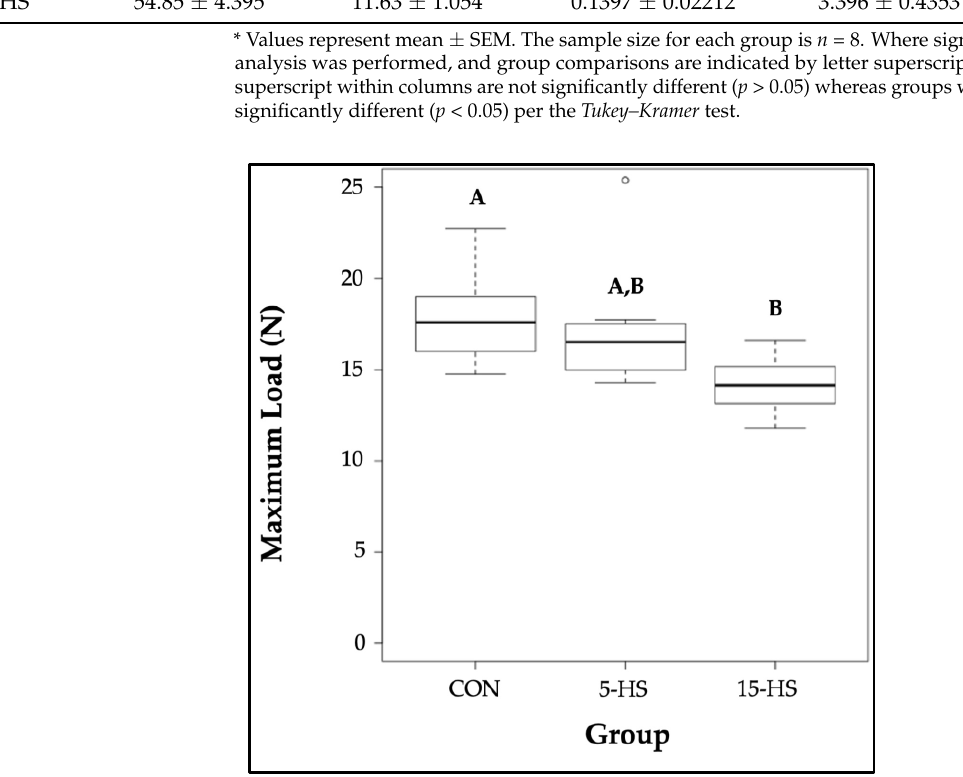
Figure 6. Boxplots of maximum load (N) of the right femur between diet groups. CON (median = 17.59, IQR = 2.60, range = 14.75 – 22.74), 5-HS (median = 16.52, IQR = 2.23, range = 14.28 – 25.38), and 15-HS (median = 14.14, IQR = 1.75, range = 11.78 – 16.62). Groups sharing the same letters above